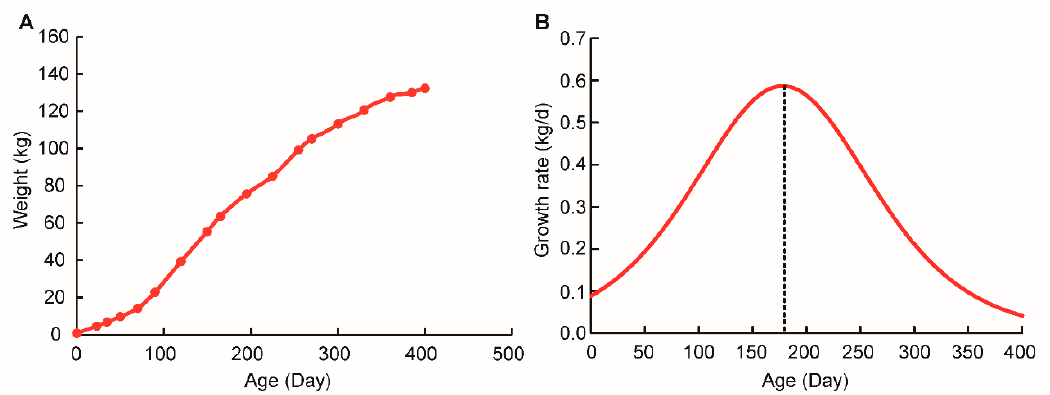
Figure 1. Growth curve of Qingyu pigs. ( A ) Sigmoidal curve fitted using logistic model, n = 126. ( B ) Daily gain of Qingyu pigs fitted by using a logistic equation, n = 126.